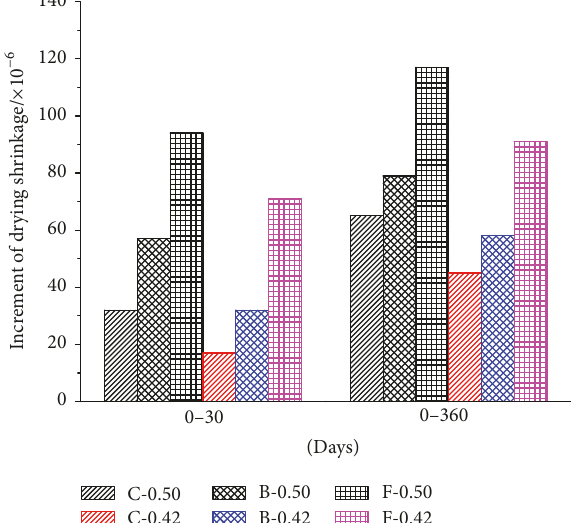
Figure 10: The increments of drying shrinkage of concretes when the wet curing time decreases from 5 days to 2